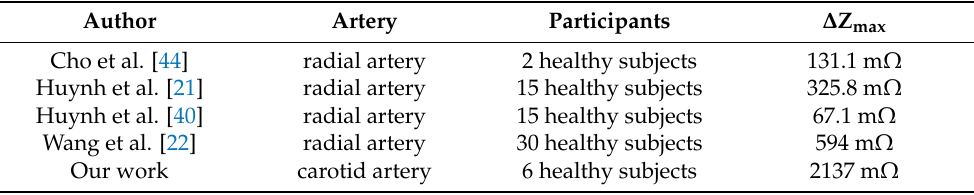
Table 2. Performance comparison for IPG-based arterial pulse